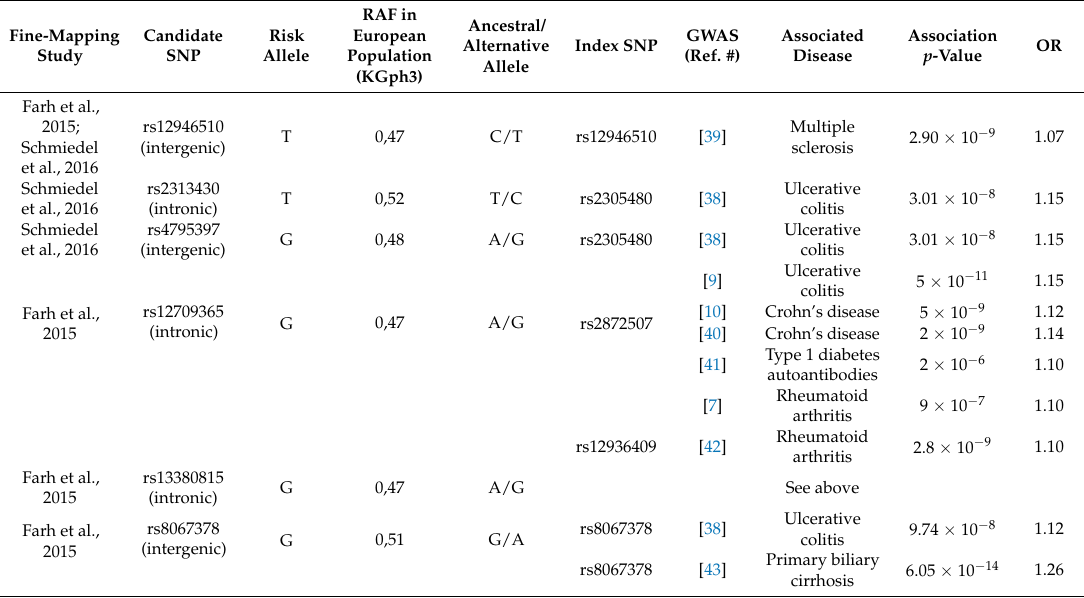
Table 5. Association data for the candidate functional single-nucleotide polymorphisms (SNPs) in